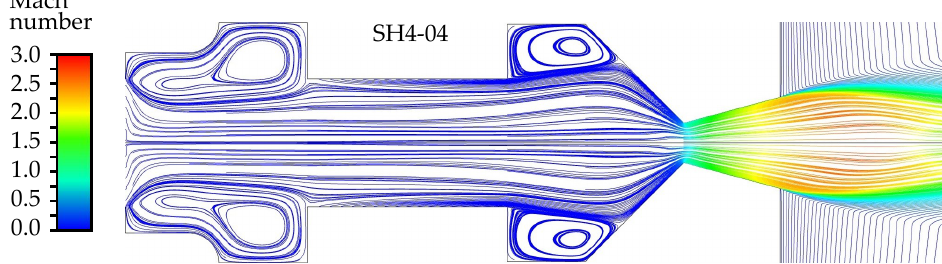
Figure 12. Streamlines for case SH4-04, colored by Mach